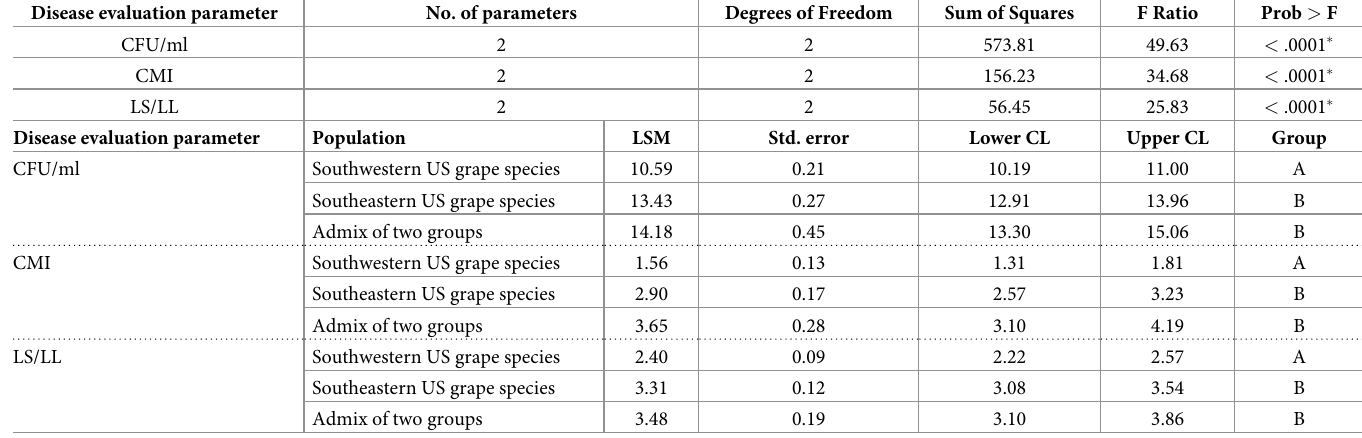
Table 4. Two-way ANOVA of the three groupings of three Pierce’s disease evaluation parameters: ELISA readings of bacterial levels in the stem (CFU/ml), cane maturation index (CMI), and leaf scorch/leaf loss (LS/LL). a. There was significant variation among the three groups for the three parameters. b. Least square means (LSM) comparisons of three Pierce’s disease evaluation parameters based on ELISA readings of bacterial levels in the stem (CFU/ml), cane maturation index (CMI), and leaf scorch/leaf loss (LS/LL) using Tukey’s test for three groups. Results significantly separate the southwestern US species from the southeastern US grape species across all three parameters of disease evaluation. Confidence levels (CL) were established at